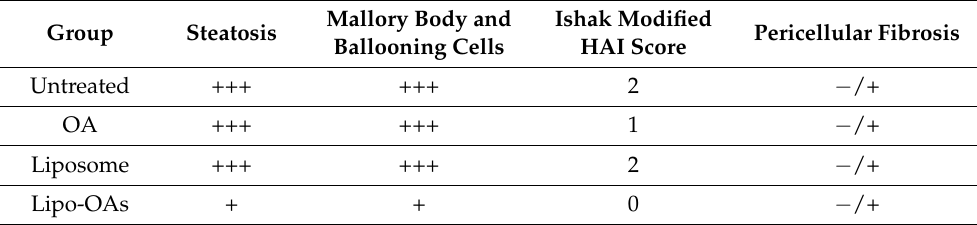
Table 3. Histological findings and scores after 4 treatment weeks in PM 2.5 and alcohol-induced inflammation liver.